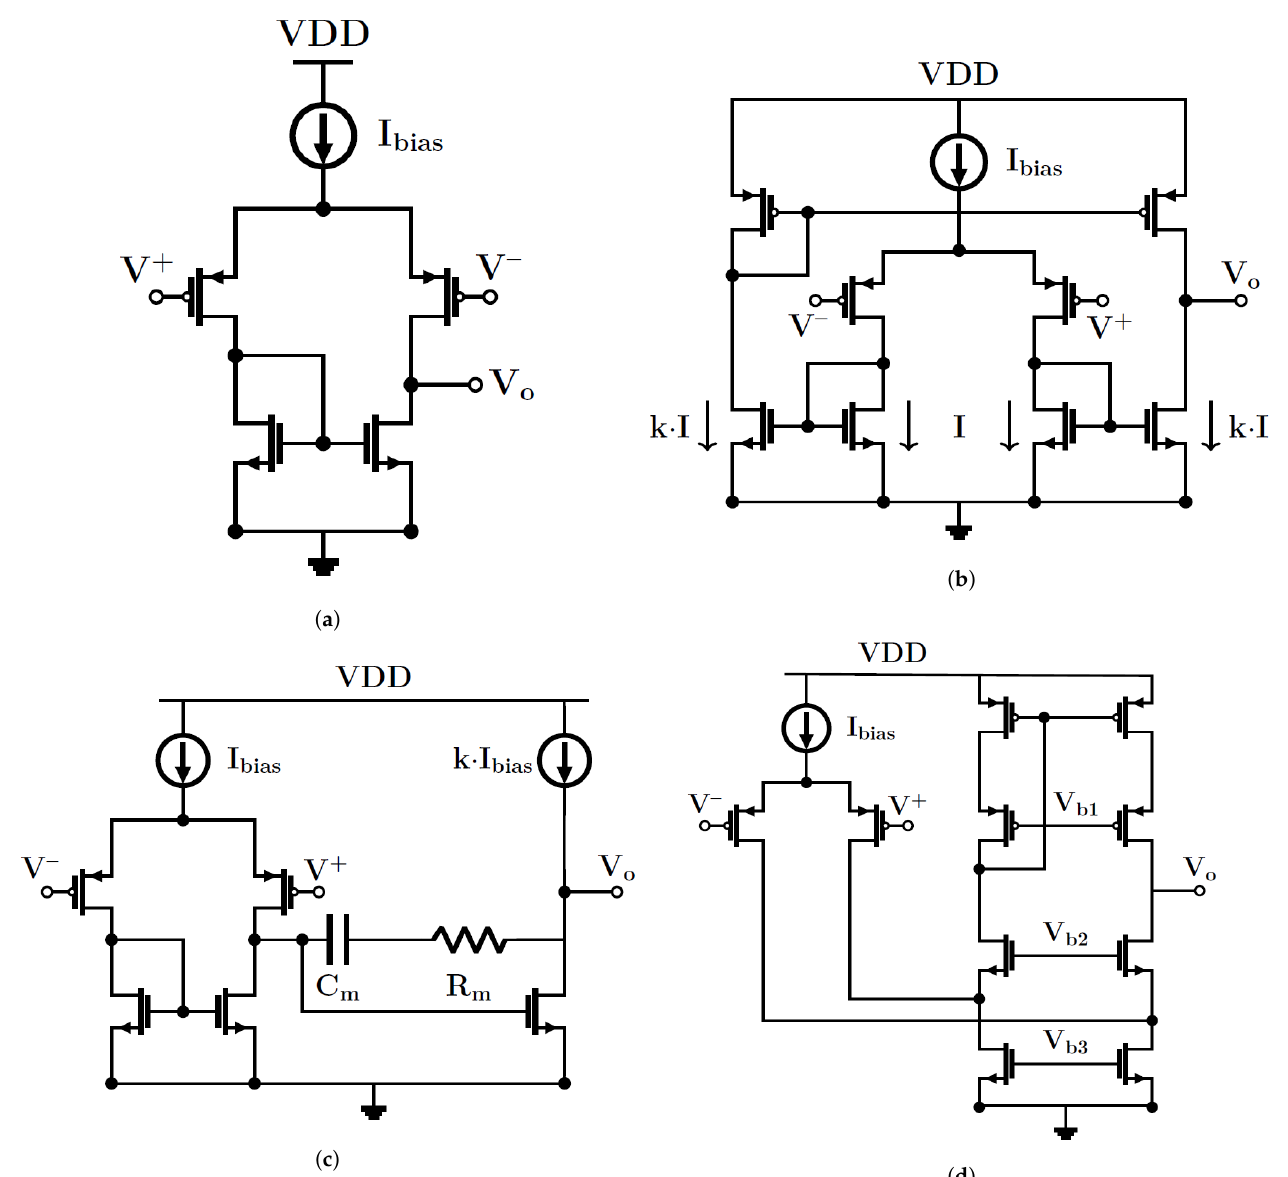
Figure 4. ( a ) Single-stage, ( b ) symmetrical, ( c ) two-stage Miller and ( d ) folded cascode